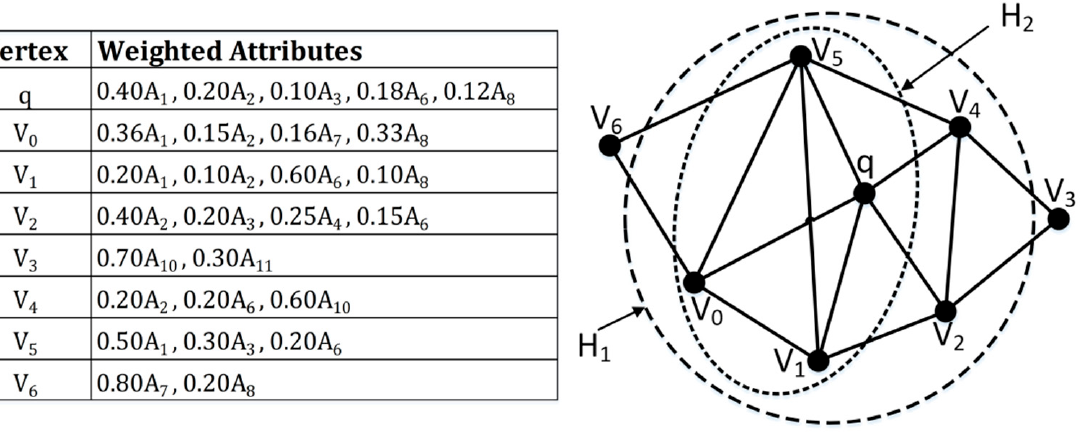
Figure 1. Geographic social network graph.